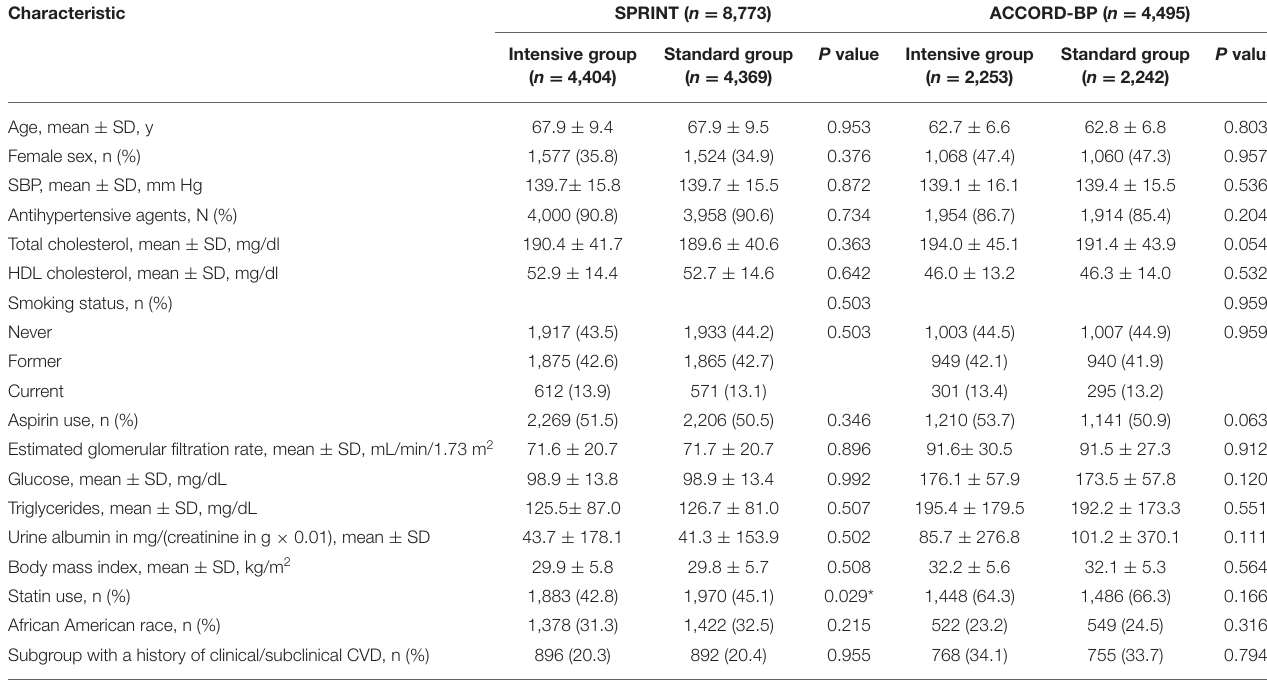
TABLE 1 | Baseline characteristics of the SPRINT and ACCORD participants included in the analysis.